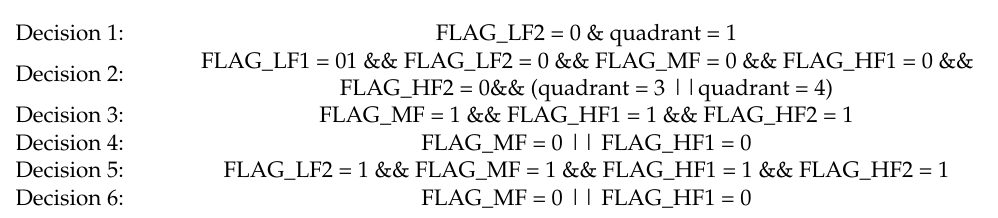
Figure 9. Flowchart of algorithms of hierarchical dimension reduction.